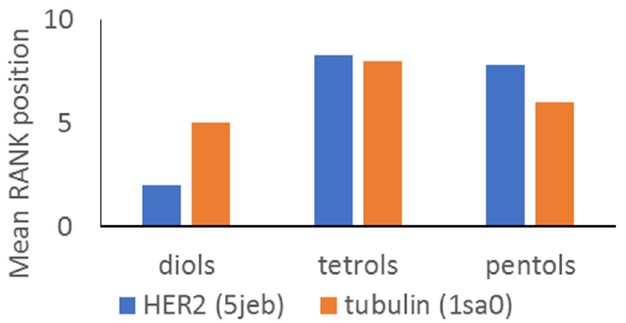
Figure 2. Mean RANK position from molecular docking to HER2 and tubulin for diols, tetrols and pentols.